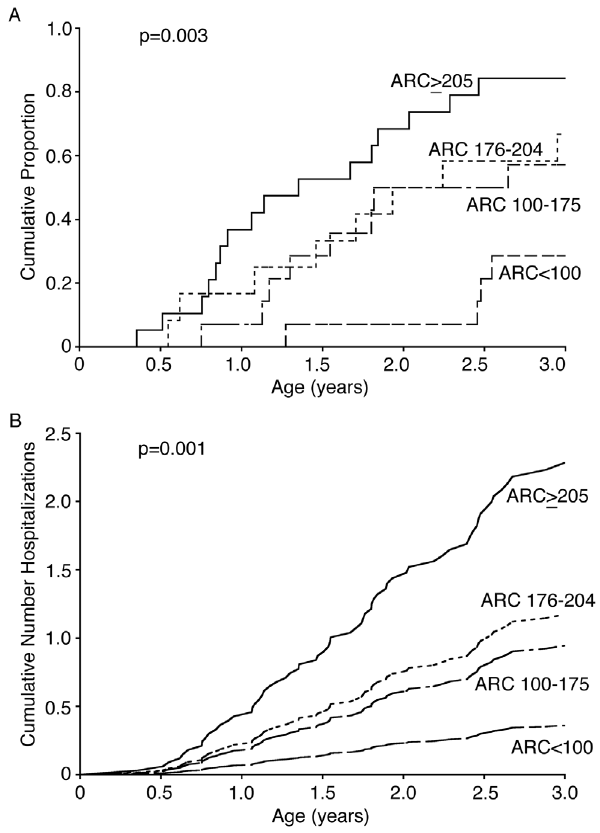
Figure 4. Time to first event and cumulative mean frequency of events. A. Kaplan Meier curve showing the cumulative proportion of events by patient groups. The groups were divided by absolute reticulocyte count based on the ROC curve seen in Figure 3 [absolute reticulocyte count . 205 K/uL (solid line, n=19, 0.84, 95% CI 0.68–1.01), absolute reticulocyte count between 176 and 204 K/uL (dotted line, n=12, 0.67, 95% CI 0.40–0.93), absolute reticulocyte count between 100 and 175 K/uL (dashed & dotted line, n=14, 0.57, 95% CI 0.31–0.83), absolute reticulocyte count , 100 K/uL (dashed line, n=14, 0.29, 95% CI 0.05–0.52)]. B. Cumulative mean frequency of events curves (cumulative frequency of hospitalizations on the y-axis vs. age in years on the x-axis) for the groups described in panel A [absolute reticulocyte count . 205 (cumulative mean frequency of events 2.28, 95% CI 1.49–3.49), absolute reticulocyte count 176–204 (cumulative mean frequency of events 1.17, 95% CI 0.67–2.04), absolute reticulocyte count 100–175 (cumulative mean frequency of events 0.94, 95% CI 0.51–1.75), absolute reticulocyte count , 100 (cumulative mean frequency of events 0.36, 95% CI 0.15– 0.88)]. In both panels, the p value represents the differences among the four groups. ARC, Absolute Reticulocyte Count.